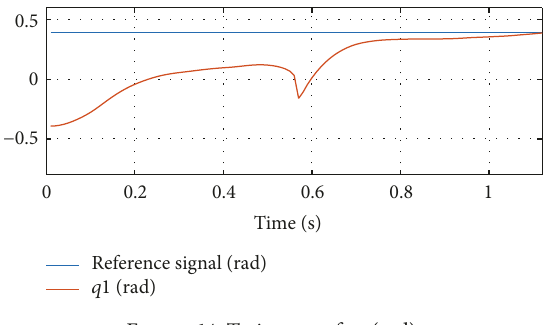
Figure 14: Trajectory of 𝑞 1